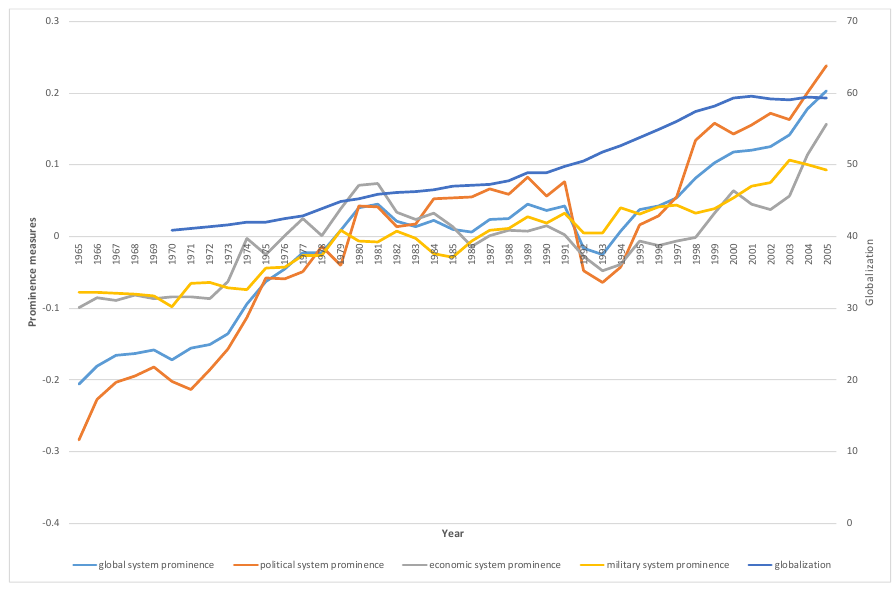
Figure 2: Evolution of Mean Prominence Scores (1965-2005) and Globalization